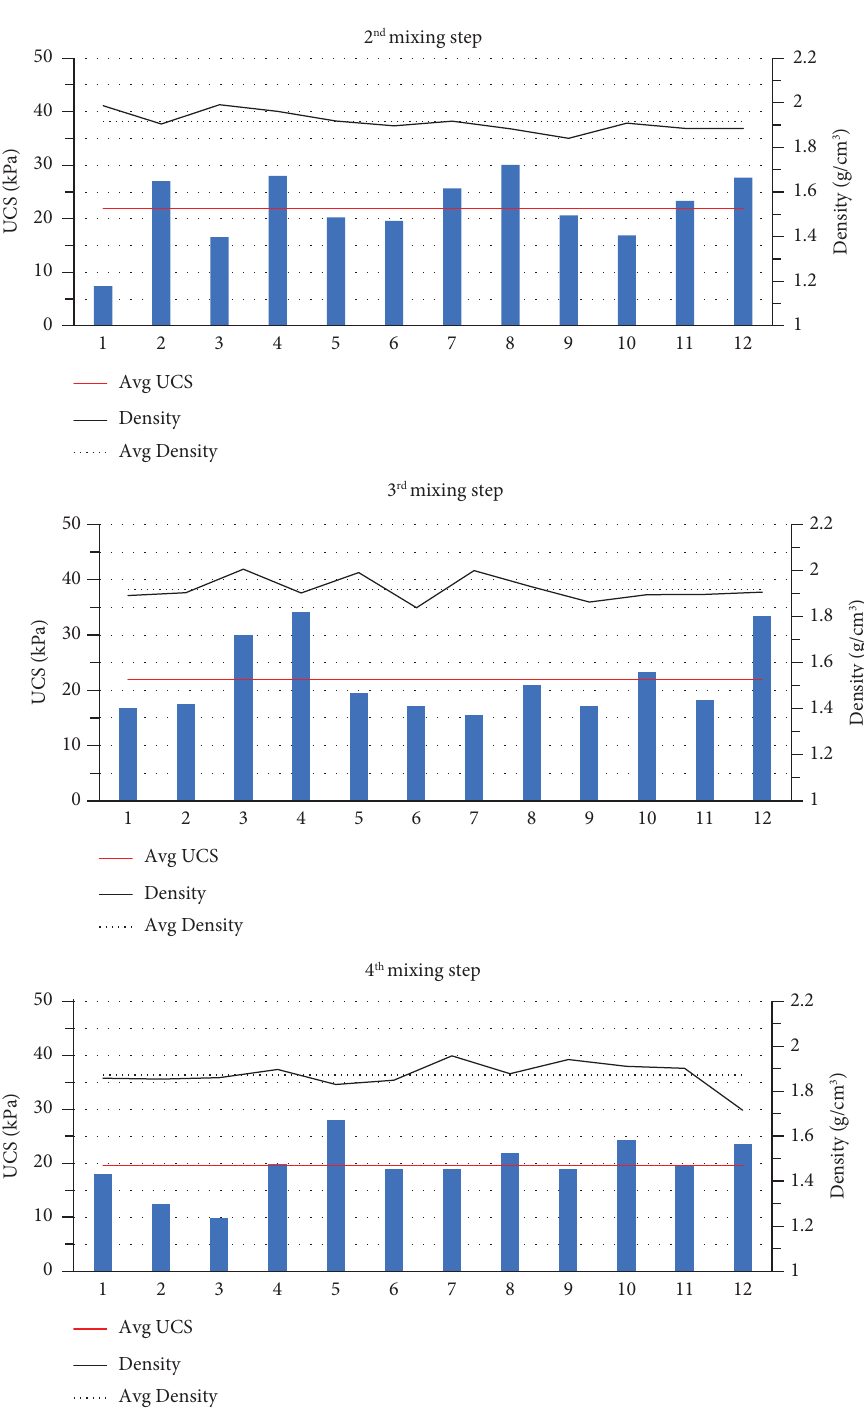
Figure 8: UCS of samples for mixing steps after 28 days of curing